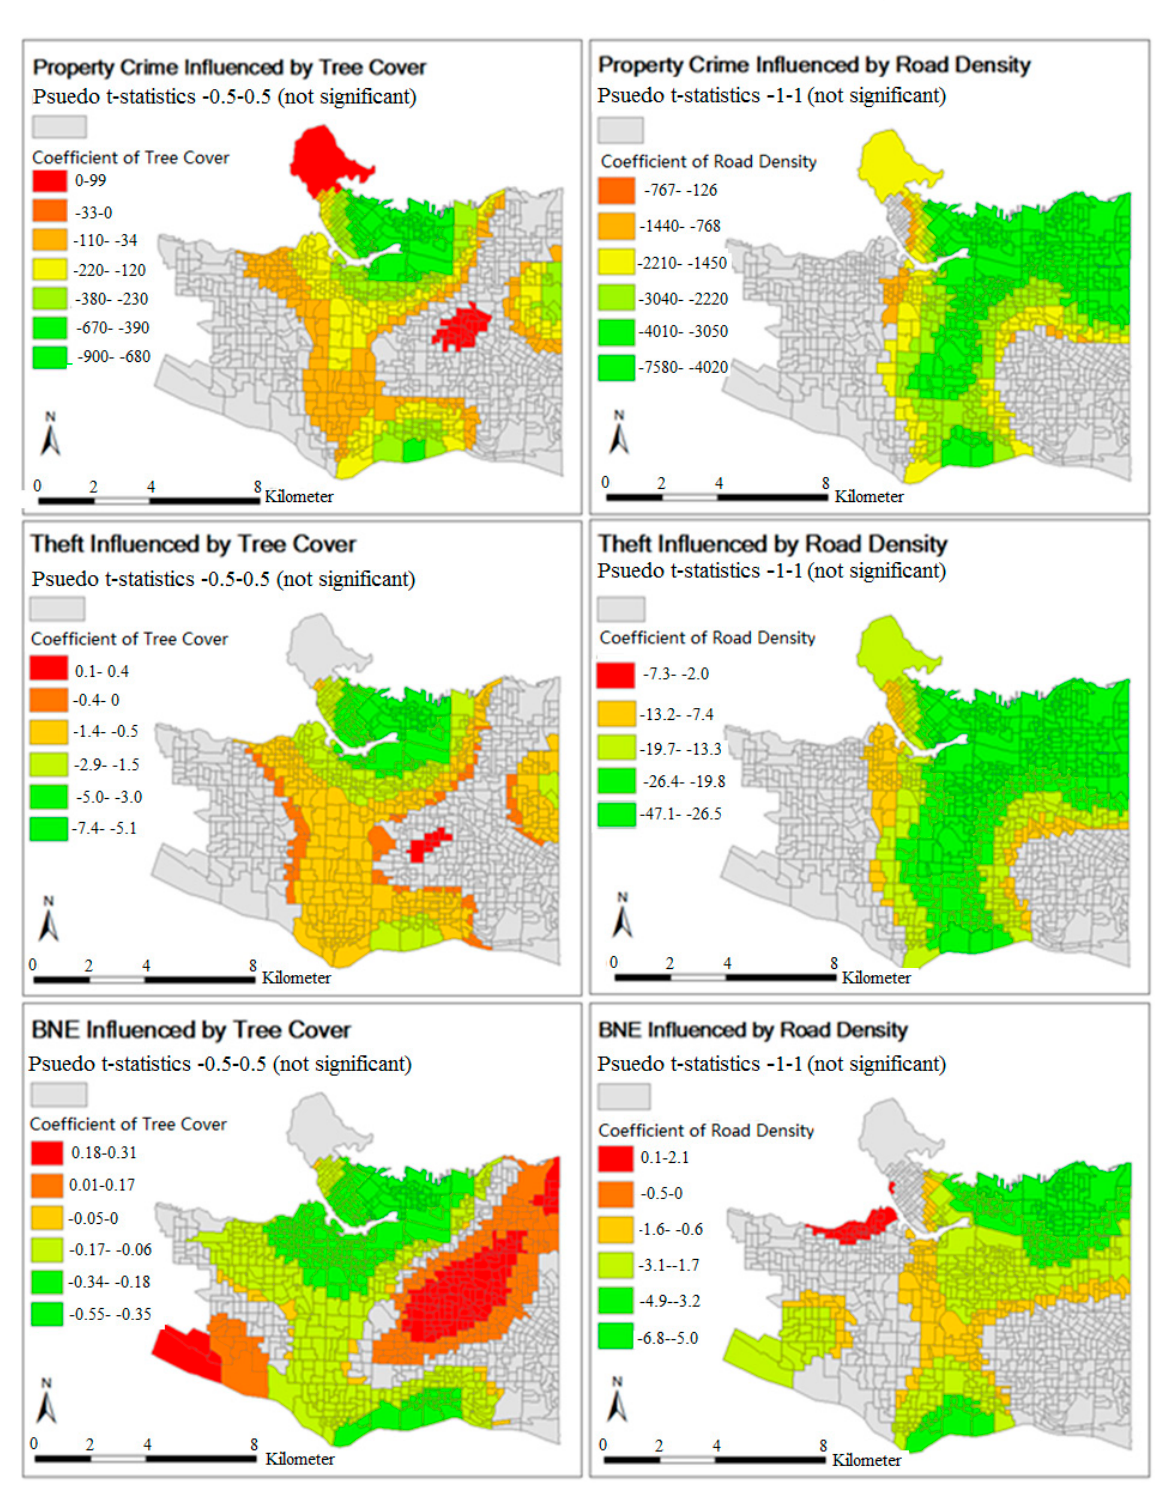
Figure 2. Geographically Weighted Regression (GWR) maps showing spatial variation of the local tree coverage coefficients. coverage